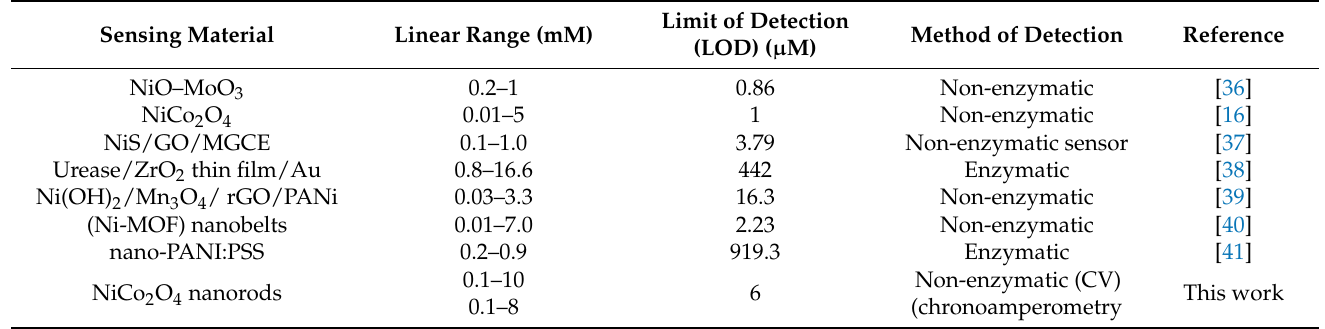
Figure 5. ( a ) chronoamperometry response of Sample 2 based on NiCo 2 O 4 nanomaterial, at 0.6 V in the presence of various urea concentrations prepared in 0.1 M NaOH, ( b ) Linear plot of amperometeric generated current against various urea concentrations. Table 1. Performance evaluation comparative analysis of NiCo 2 O 4 with recently published urea